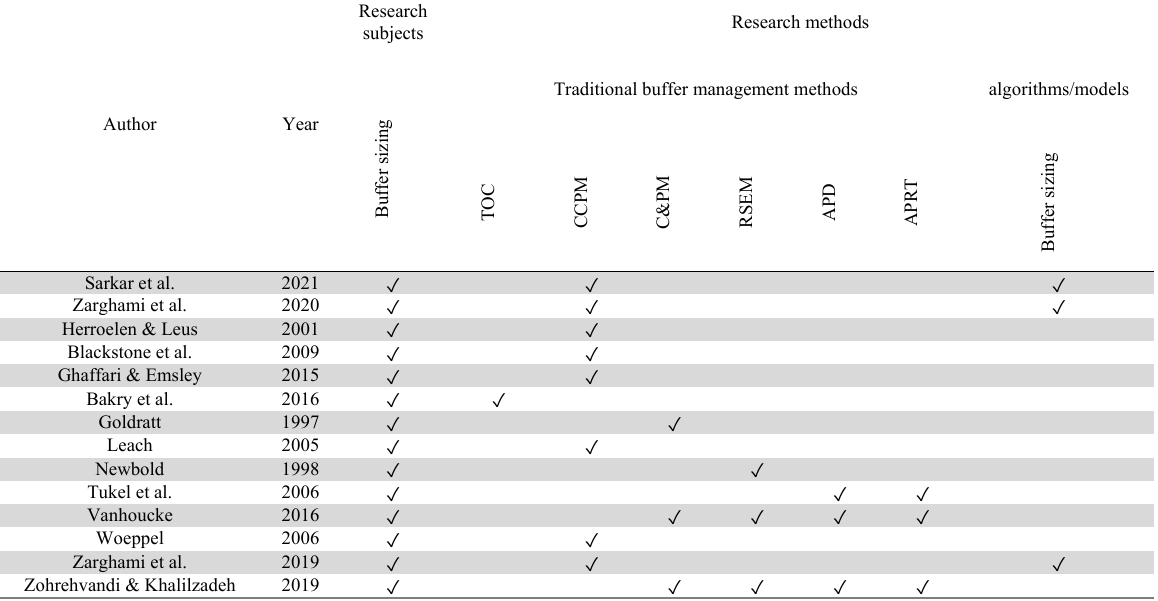
Project buffer sizing: Traditional buffer management methods